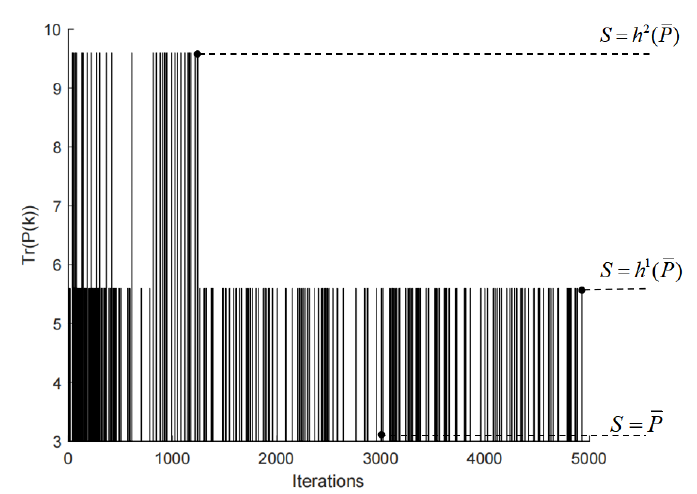
Figure 5. Variation of Tr ( P ( k )) for unreliable channel.